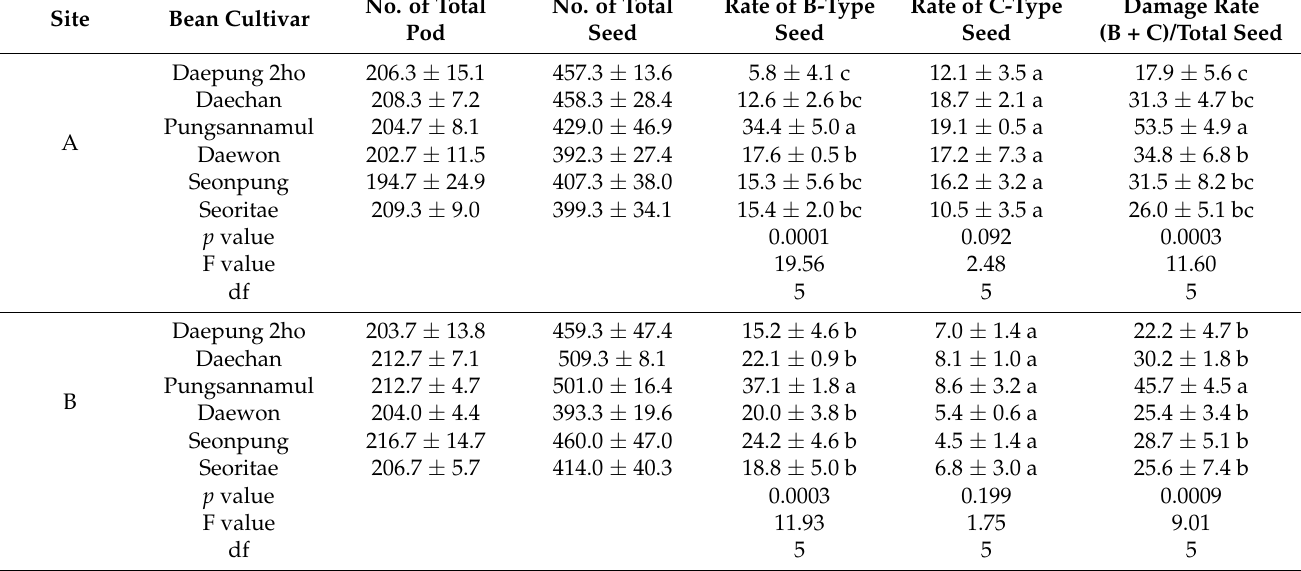
Values represent the mean ± SD. Means followed by the same letters in a column are not significantly different among soybean cultivars (ANOVA, Tukey’s HSD test, p <